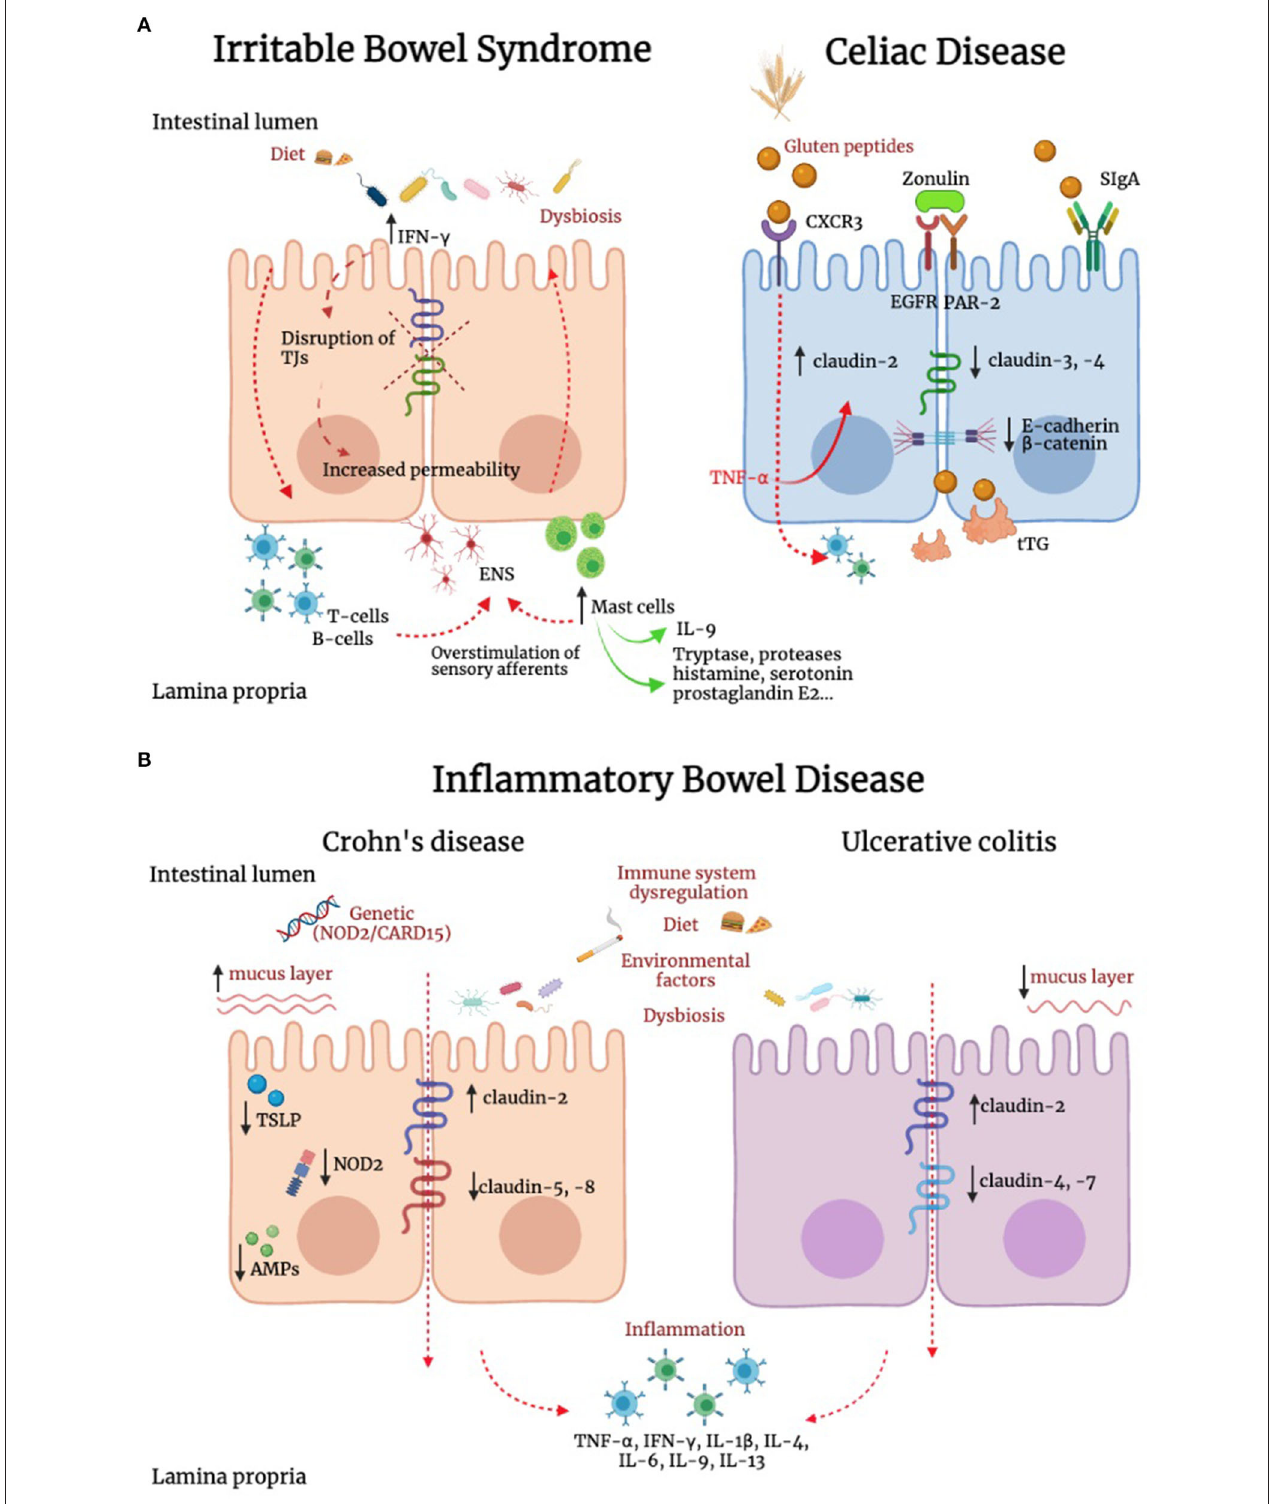
FIGURE 2 | Alteration of IEB in irritable bowel syndrome, inflammatory bowel disease and celiac disease. (A) In irritable bowel syndrome (IBS), tryptase, histamine, and interferon- γ (IFN- γ ) are increased and can contribute to TJ disruption. In addition, IL-9 is produced by innate lymphoid cells, T helper cells and mast cells. This